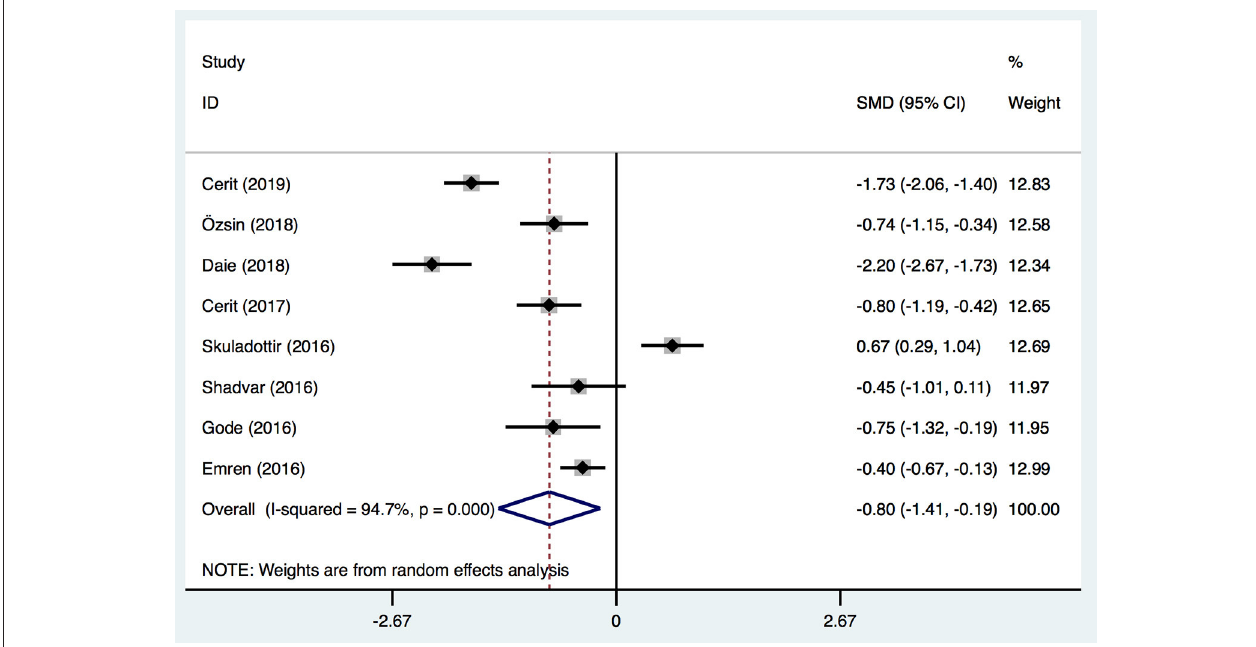
FIGURE 5 | Forest plot for the relationship between VitD level and severe outcomes post-operation identified in the meta-analysis of eight trials using random-effect model. Only the first author of each study is given. Test for overall effect, z = 2.58, P = 0.01; test for heterogeneity, I 2 = 94.7%, P = 0.00. SMD, standard mean difference. CI, confidence interval.